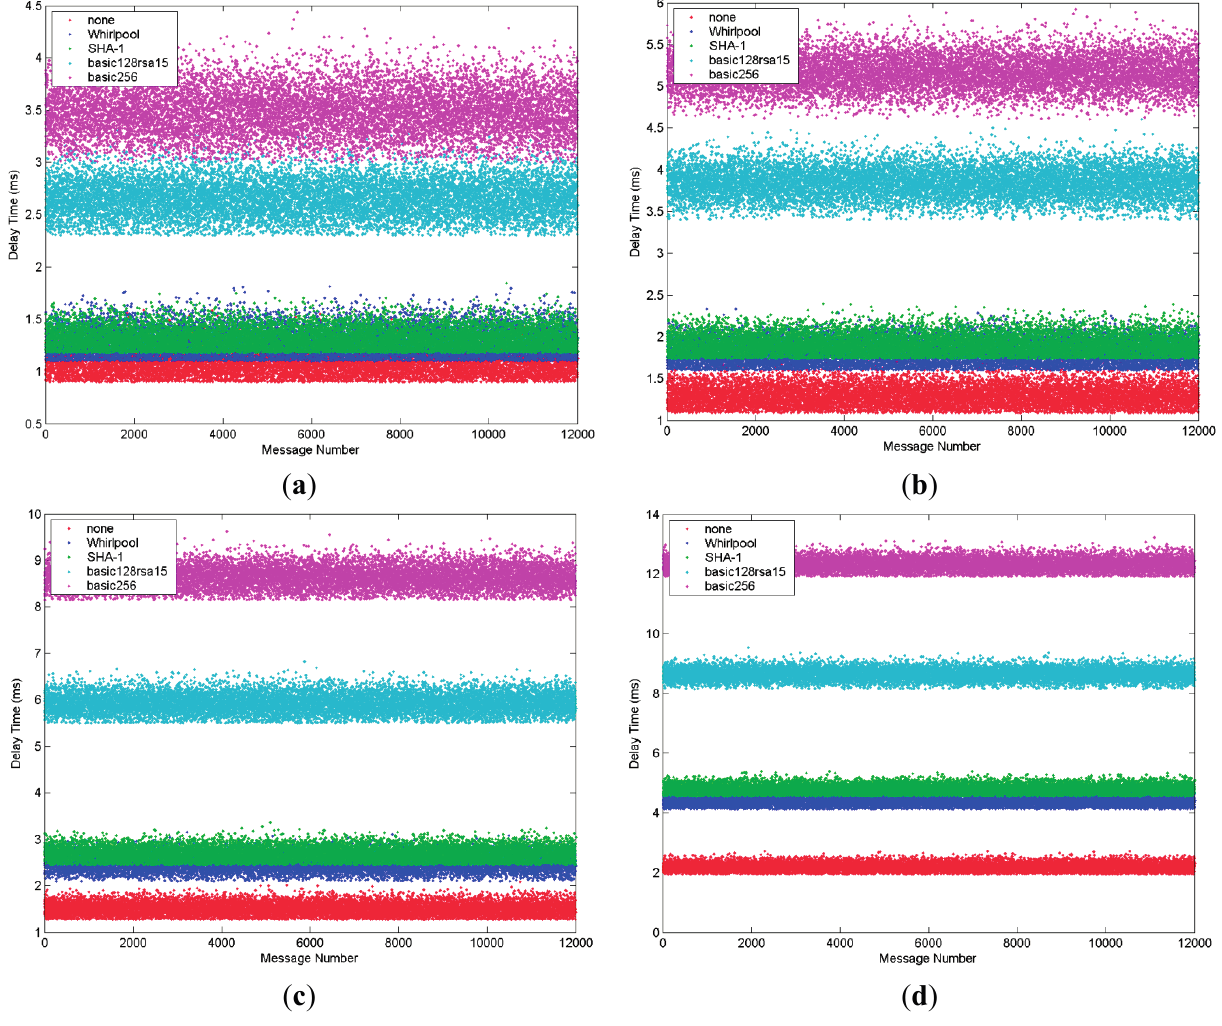
Figure 6. Comparison of delay time in different lengths of messages. ( a ) In the length of 1024 bytes; ( b ) In the length of 4096 bytes; ( c ) In the length of 8192 bytes; ( d ) In the length of 16,384